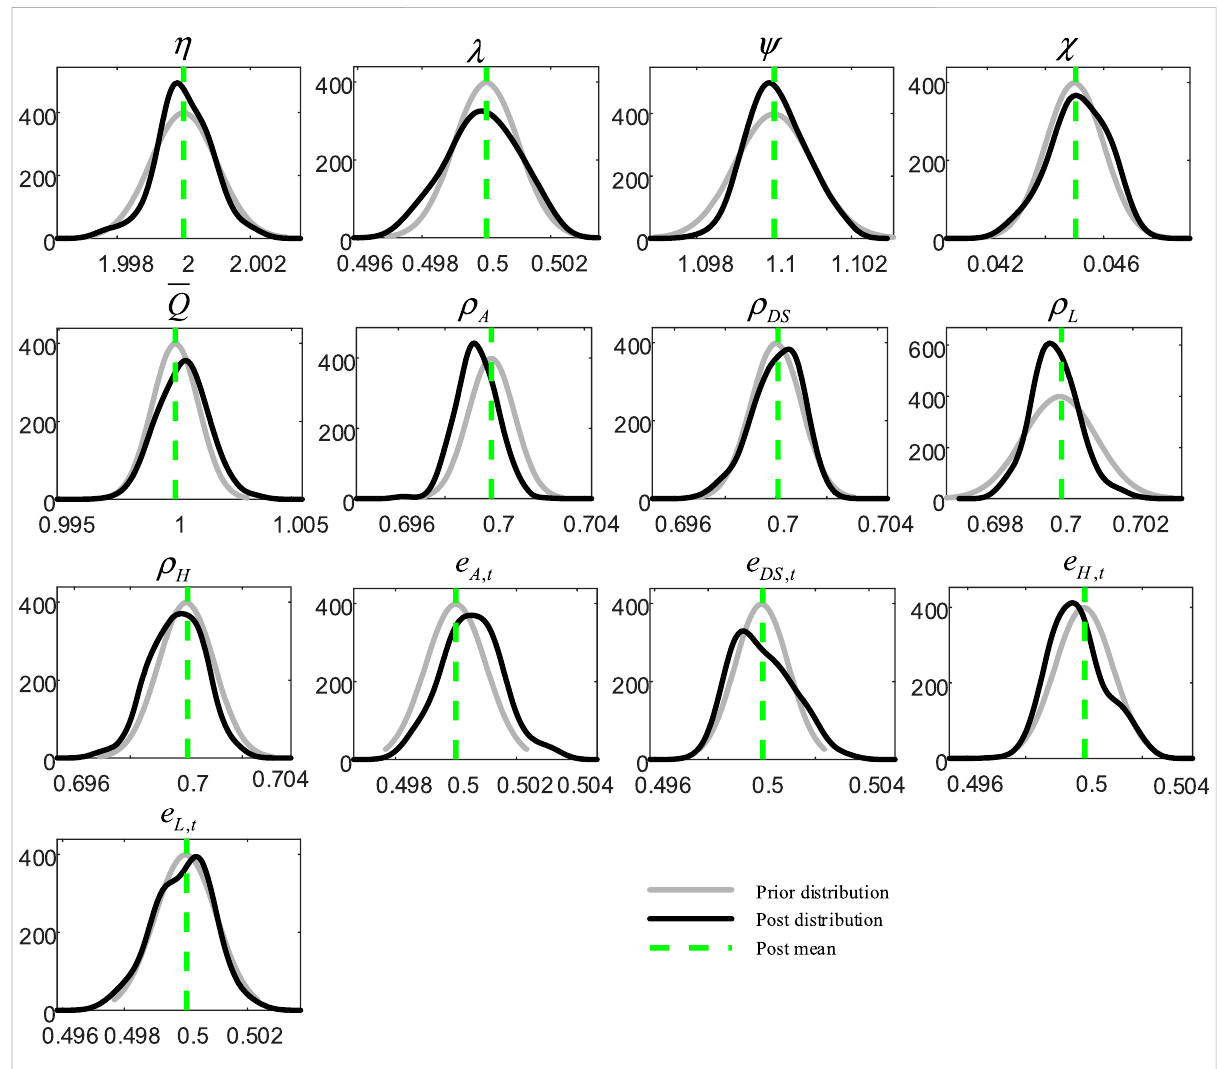
FIGURE 2 Results of bayesian